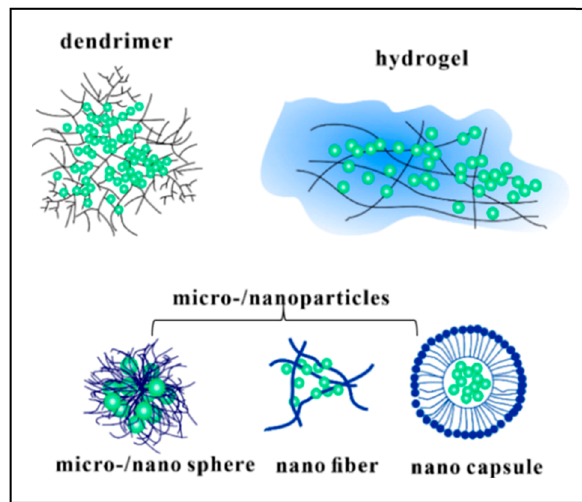
Figure 23: Schematic illustration of di ff erent carrier - based drug - releasing biomaterials [ 23 ] . Copyright 2020,